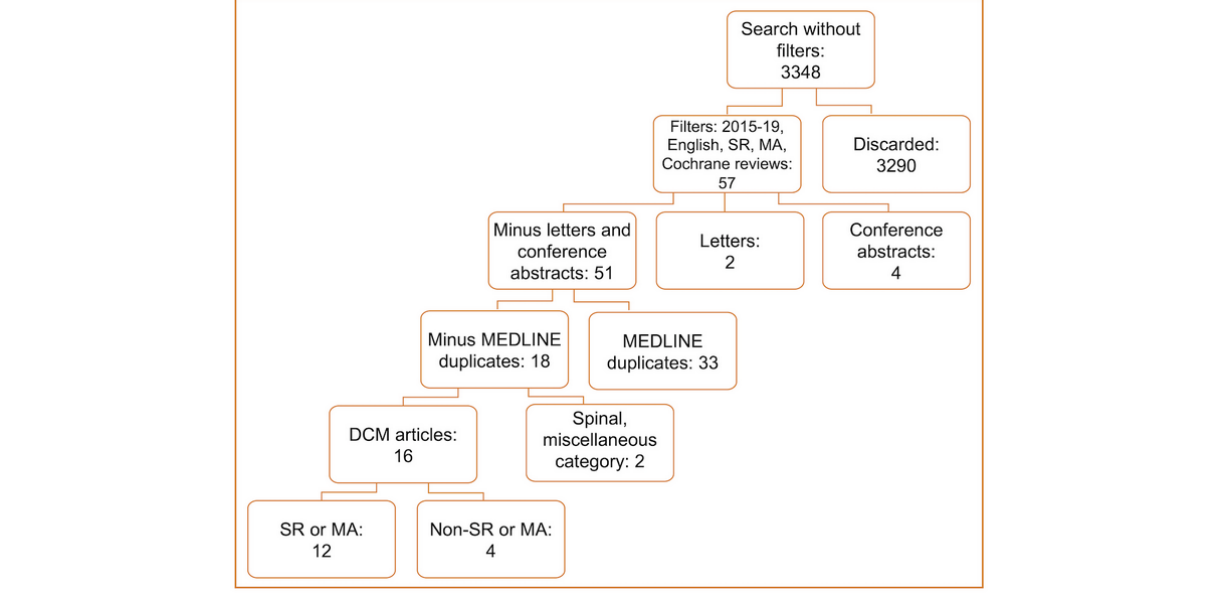
Figure 2. EMBASE search strategy and results. CNS: cerebral nervous system; DCM: degenerative cervical myelopathy; MA: meta-analysis; SR: systematic